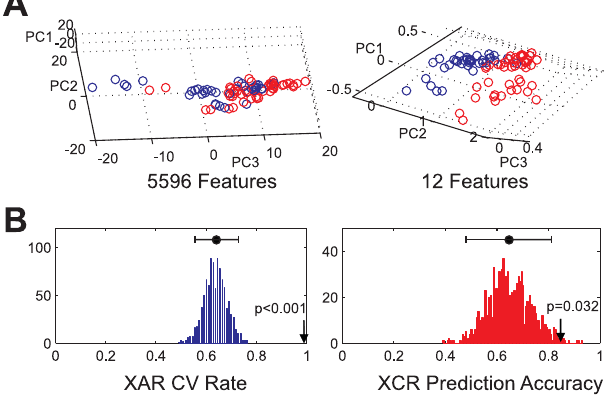
Figure 4. The Significance of the 12 Selected Features (A) The three best principal components (PC1–PC3) among all 5,596 features for 50-kb and 100-kb windows (left) and the selected 12 features (right) for the 82 nonborder genes are shown projected onto a 3-D graph. Escaping genes are represented as blue circles and subject genes as red circles. (B) These histograms show the distribution of XAR leave-one-out CV and XCR prediction rates by SVM models constructed using 1,000 random 12- feature sets taken from the 5,596 features for 50-kb and 100-kb windows. Black dots represent mean values, flanked by 95% confidence intervals denoted by error bars representing two standard deviations (2SD). Both the XAR CV rate and XCR prediction rate achieved by the selected 12 features (black arrows) exceed 2SD, and their p values calculated based on these random trials are shown. DOI: